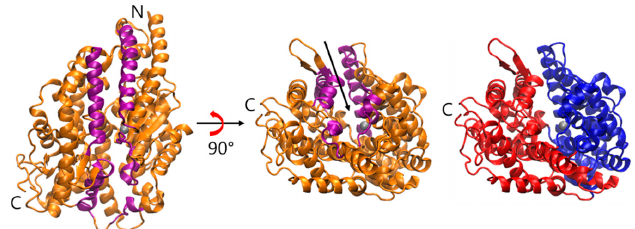
Figure 1. The overview of the structure of C domain of sACE (PDB ID: 4APH). The ribbon representation of sACE shows the secondary structure and the two lips (purple colored) of the mouth. N and C indicate the N- and C-terminus of the enzyme, respectively. Zinc ion is shown as a gray sphere. The rightmost panel shows two subdomains that form two sides of the active site in the cleft, and the subdomain I (residues 40–122, 297–437, 551–583) and II (residues 123–296, 438–550, 584–625) are colored by blue and red, respectively. The arrow indicates the active site near the zinc ion and the putative binding pathway of ligands. The first lip (residues 73–100, 297–304, 348–354, 370–379) belongs to subdomain I, and the second (109–131, 143–156, 267–276) belongs to subdomain